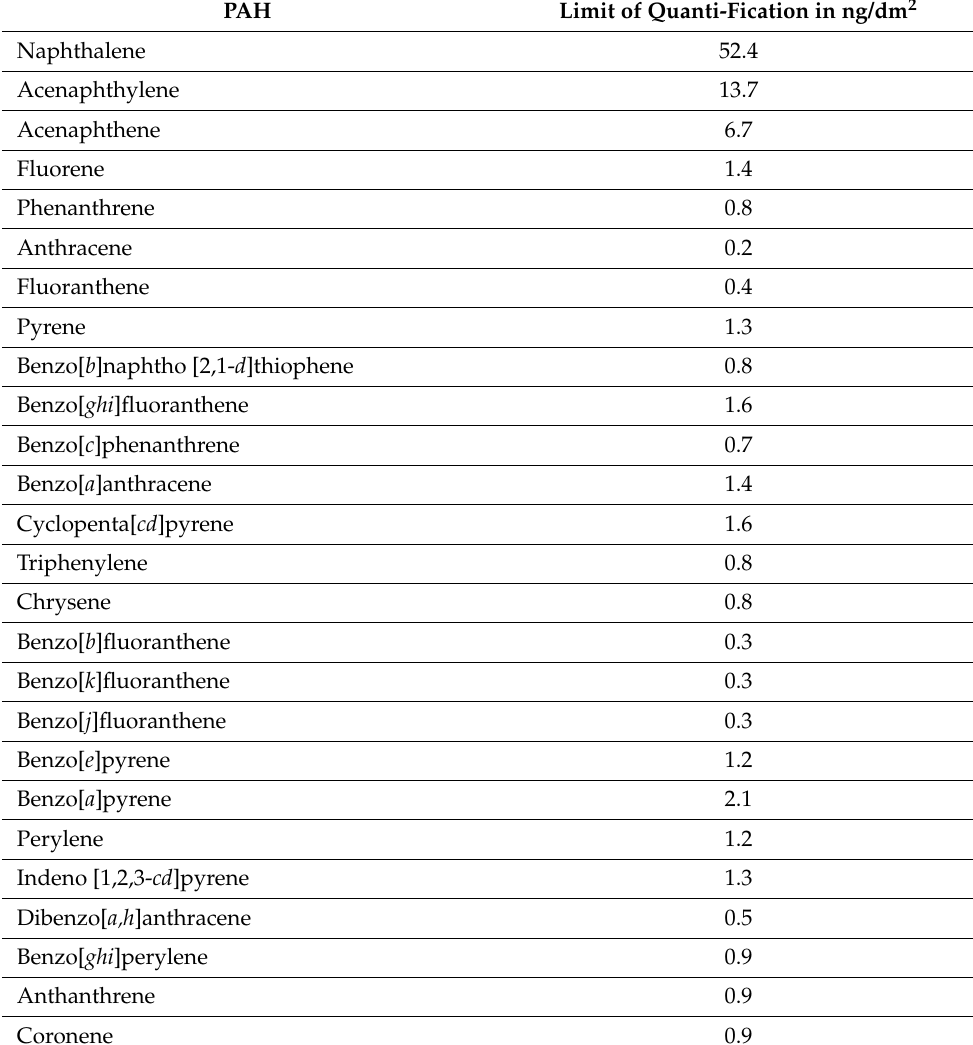
Table A2. Limits of quantification (LOQ) for the specific PAH migration rates w M .